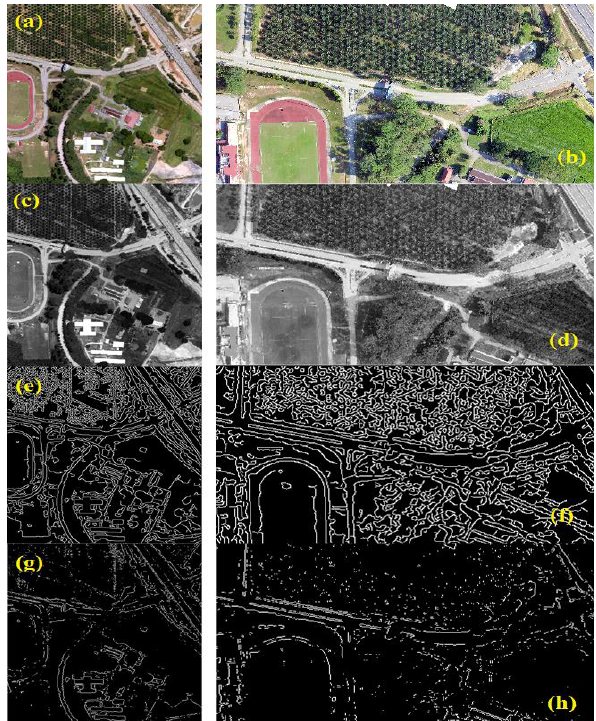
Figure 3. (a) LiDAR, (b) UAV, (c) Band 3 LiDAR, (d) Band 3 UAV, (e) Canny transformed LiDAR Band 3, (f) Canny transformed UAV Band 3, (g) Sobel transformed LiDAR Band 3, (h) Sobel transformed UAV Band 3.